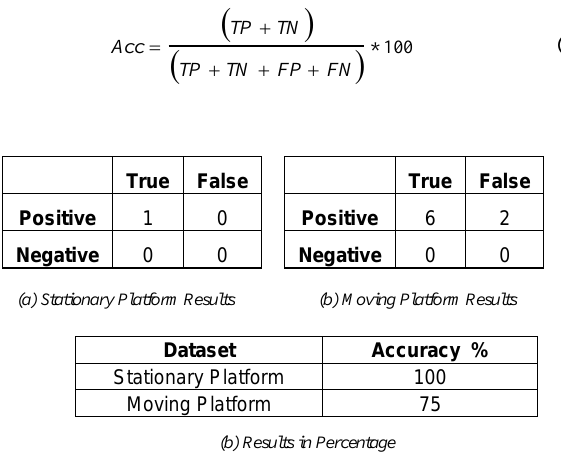
Table 2: Results of Road Intersection